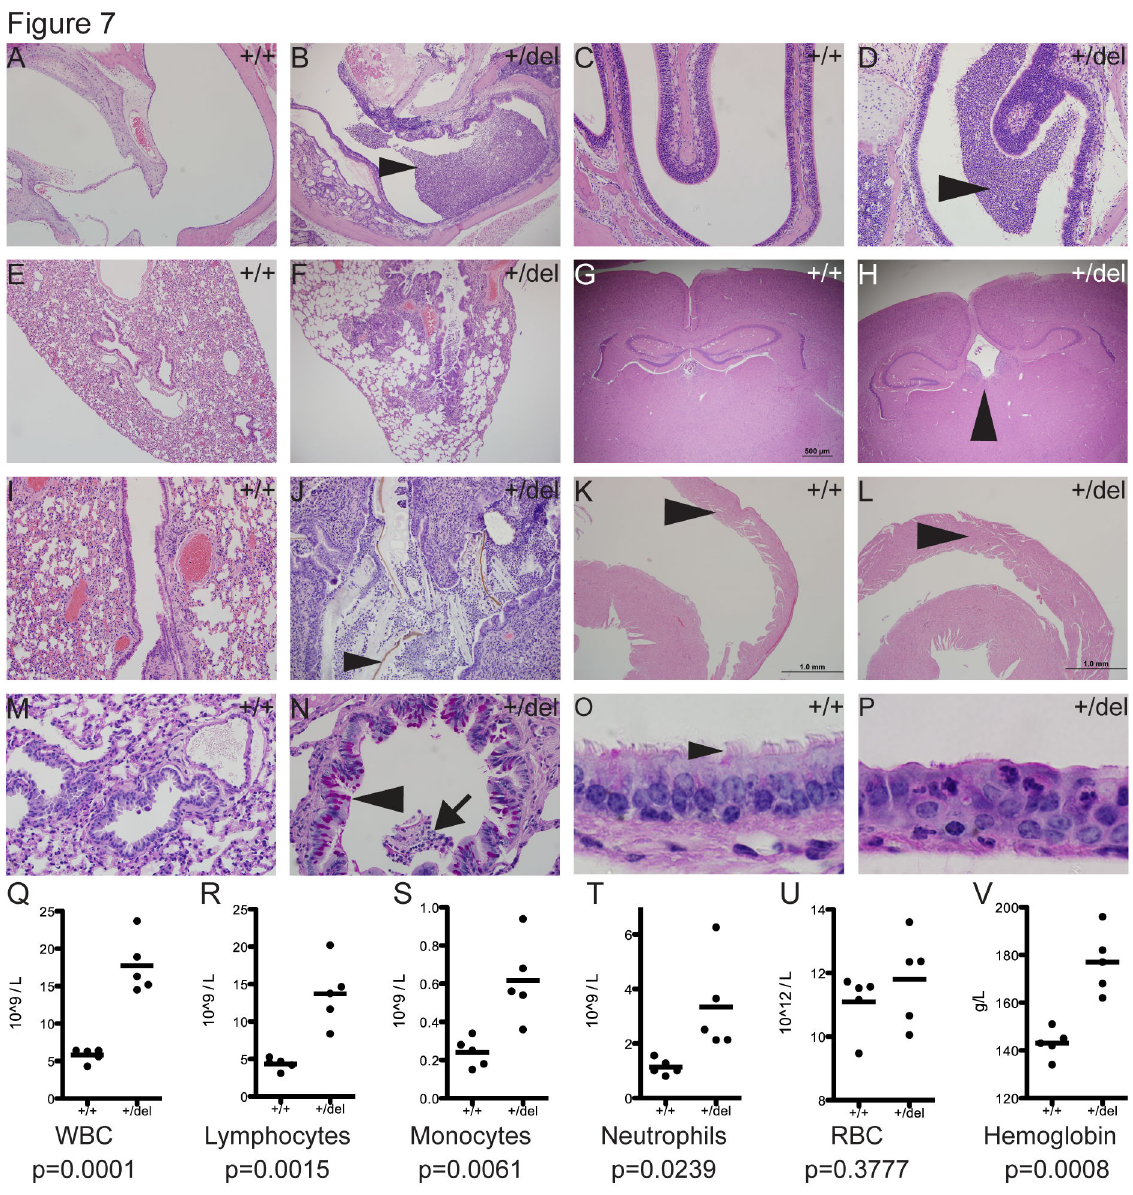
Figure 7. Novel observations in Porcn +/del FDH mouse model. In contrast to control Porcn +/+ animals, adult Porcn +/del females exhibit lesions suggestive of ciliary defects (A-H). Mutants exhibited otitis media (n=4/5, B), rhinitis (n=2/5, D), and bronchopneumonia (n=3/5, F). Mild hydrocephalus was observed in 2/5 Porcn +/del females (H). Arrowhead indicates enlarged third ventricle